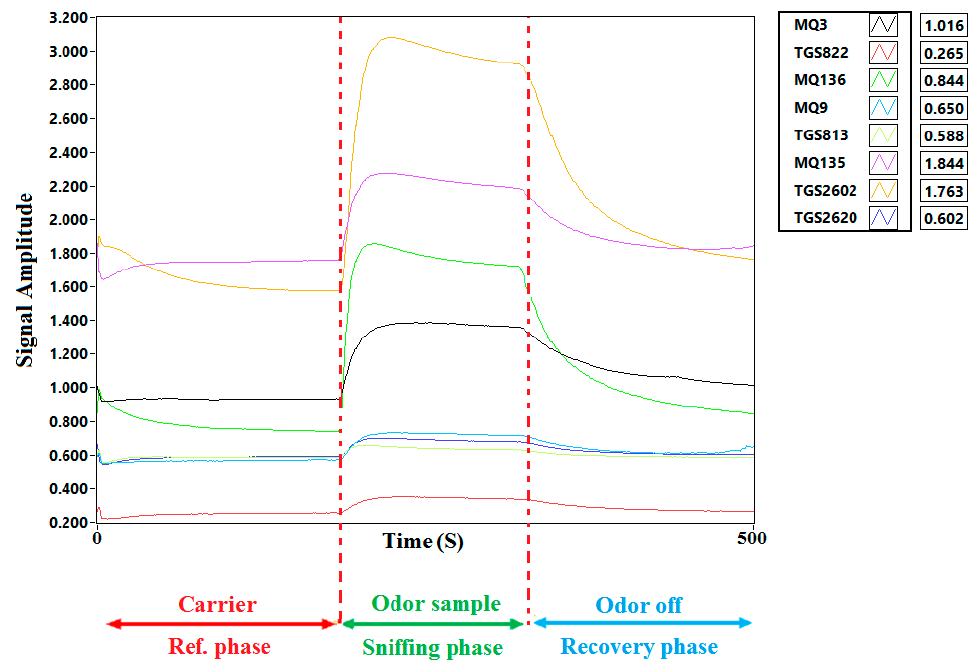
Figure 1. Typical electronic nose sensor array responses to cucumber fruit headspace volatiles (VOCs) in air samples.